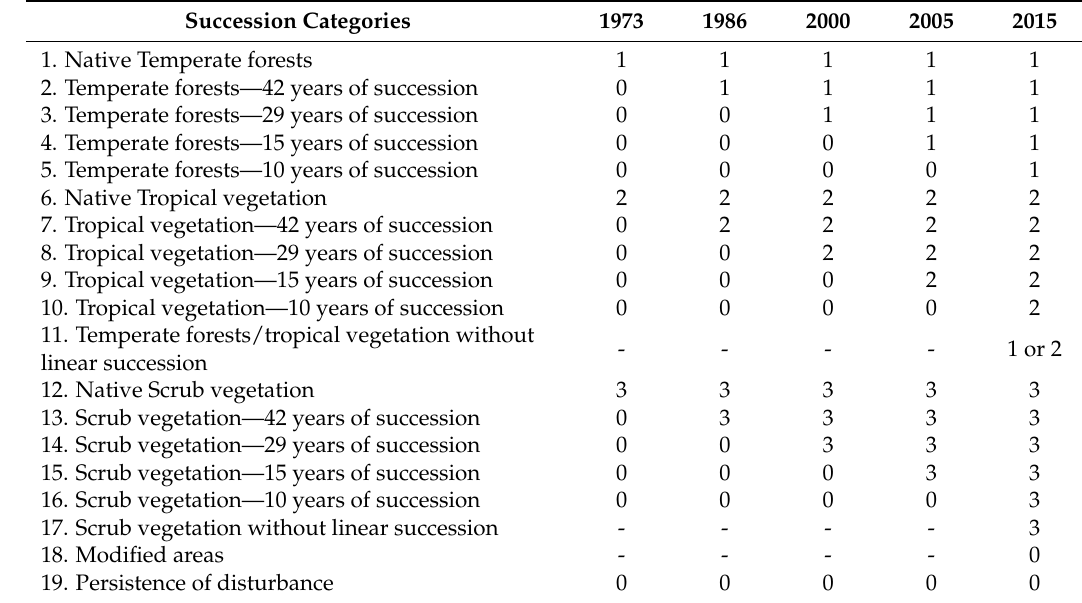
Table 3. Transition processes for the succession analysis. 0 = Disturbance (Simplified Category 0); 1 = Temperate forests (Simplified Category 1); 2 = Tropical vegetation (Simplified Category 2); 3 = Scrub vegetation (Simplified Category 3). Hyphen indicates that any value (0, 1, 2, or 3) was considered for that year (see text for